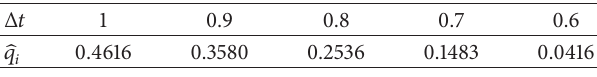
Table 1: Optimal fractional order 𝑞